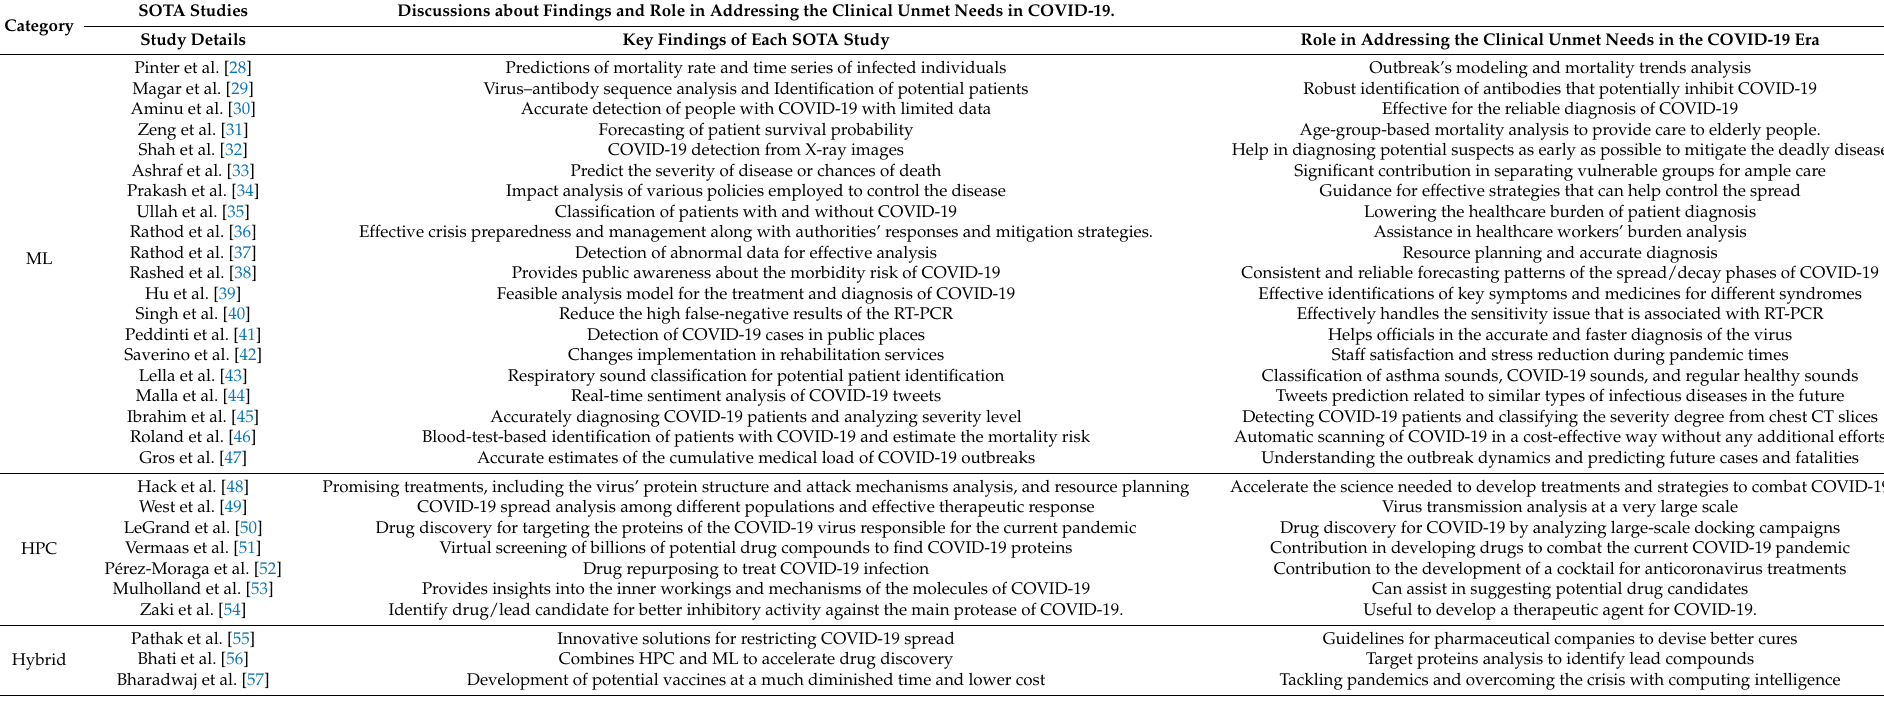
Table 2. Comprehensive overview of the current SOTA studies involving the use of ML and HPC methods in COVID-19, their key findings, and role in addressing the clinical unmet needs in the era of